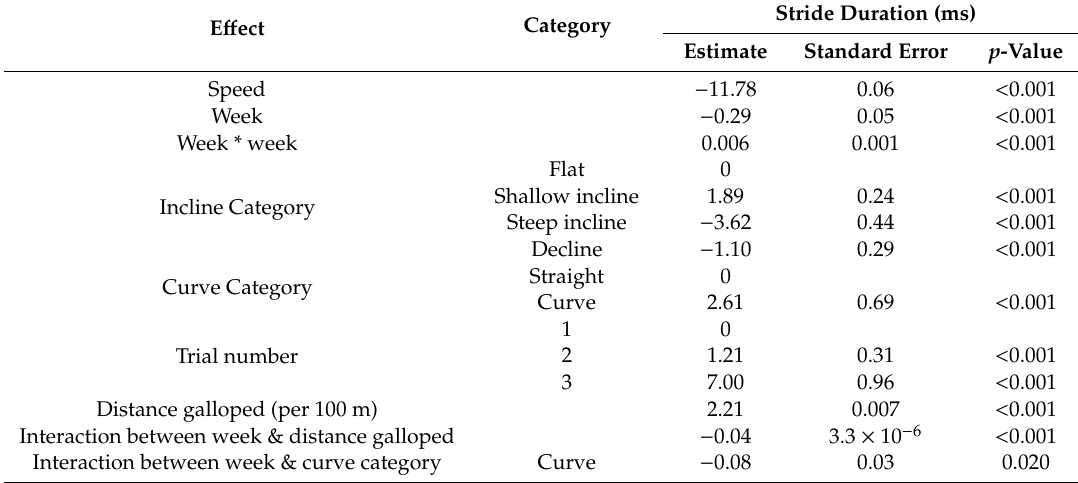
Interaction between week & curve category